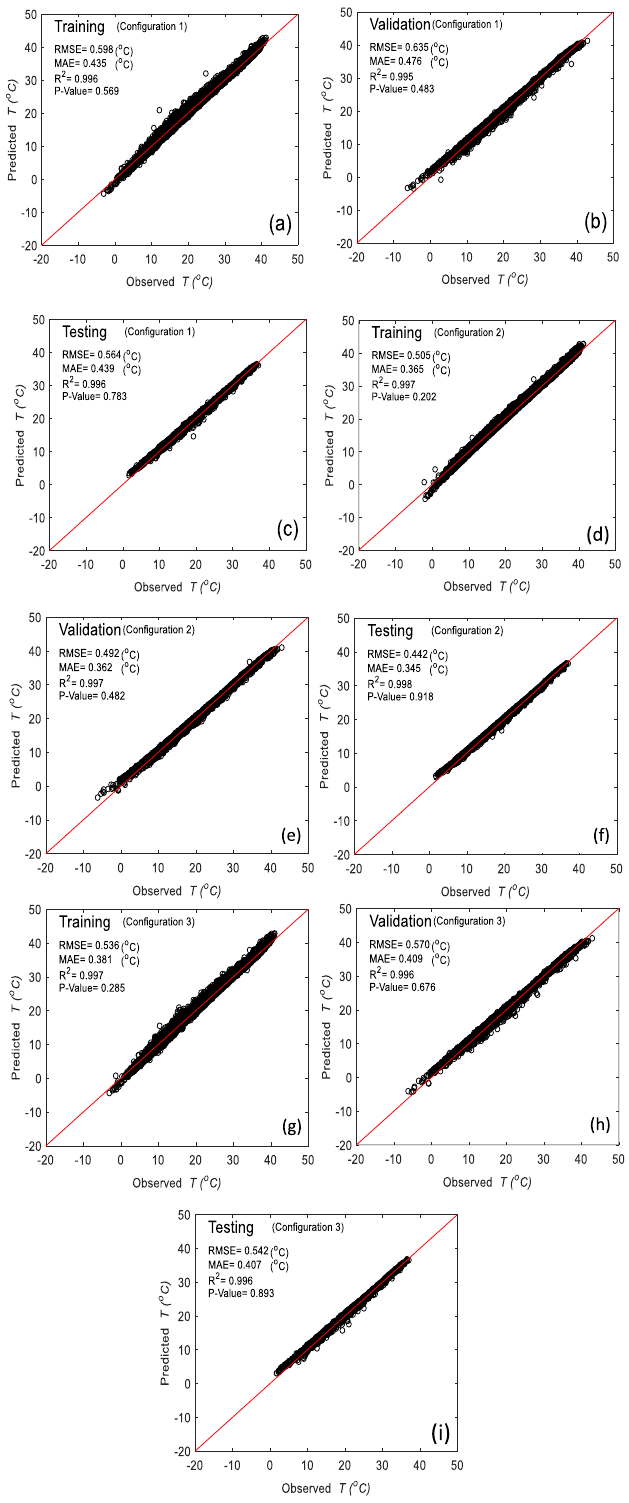
Fig. 9 Scatter plot of training, testing, validation steps, and all data for scenario